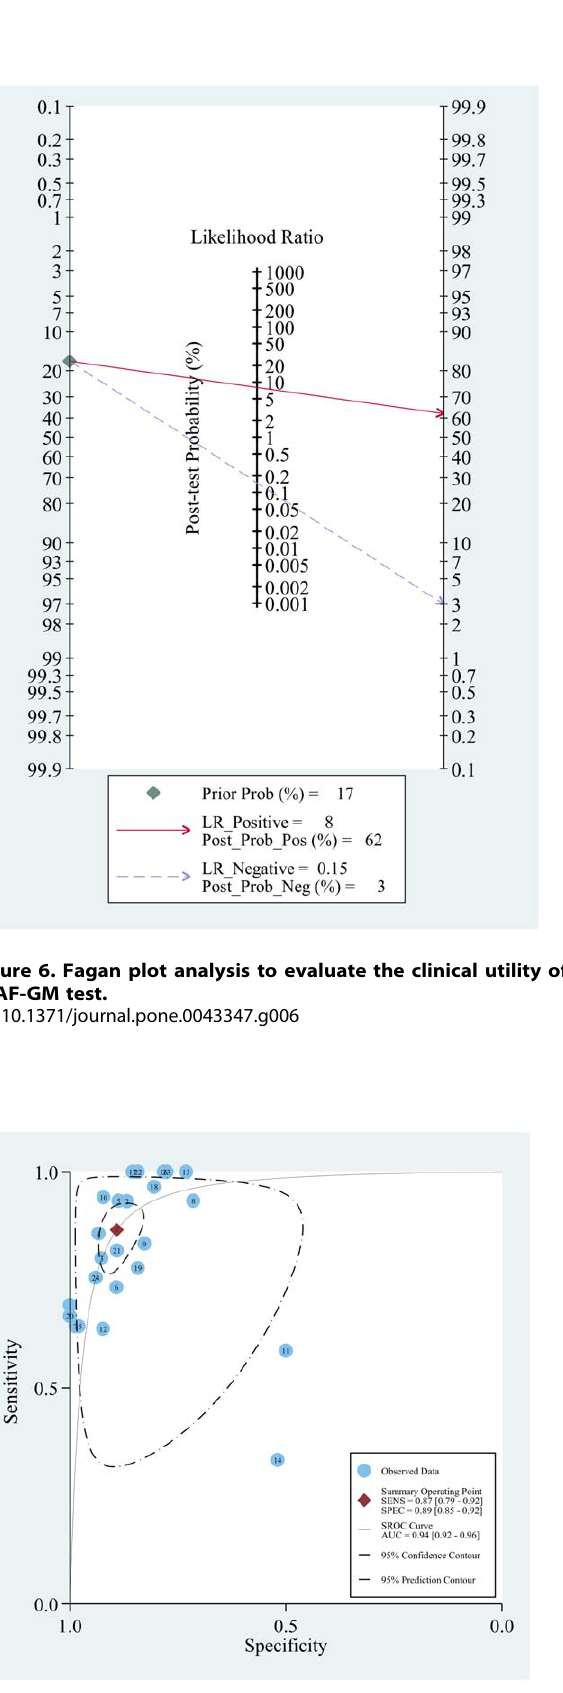
Figure 7. Funnel plot with superimposed regression line.